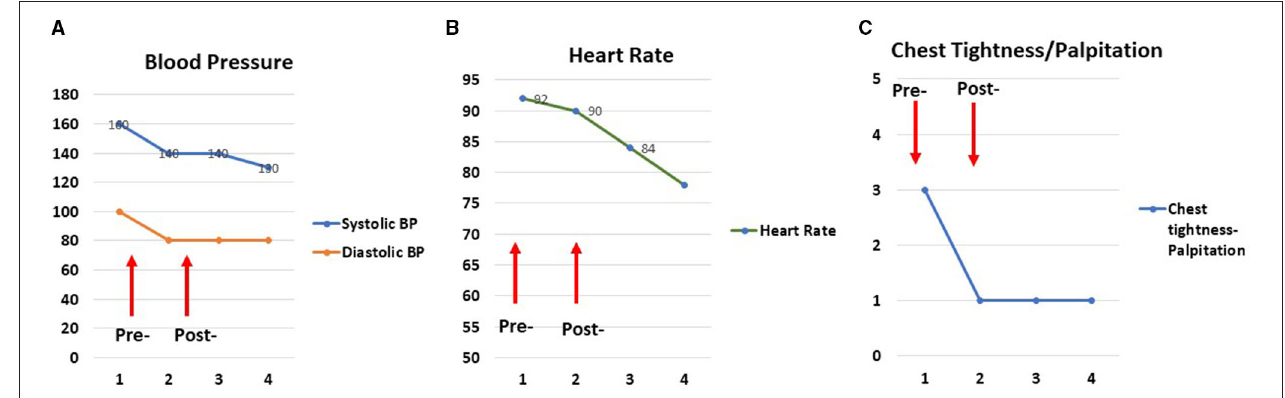
FIGURE 1 | Examples of tension relief following an individual telemusic session. Pre/post and follow-up two measurements of blood pressure (A) , heart rate (B) , and subjective physical ratings (C) for one session show tension relief following a 25-min music intervention in the participant. Two additional measures (numbers 3 and 4) were taken 6 and 12h after the intervention was completed. The physiologic effects of the music persisted for 12